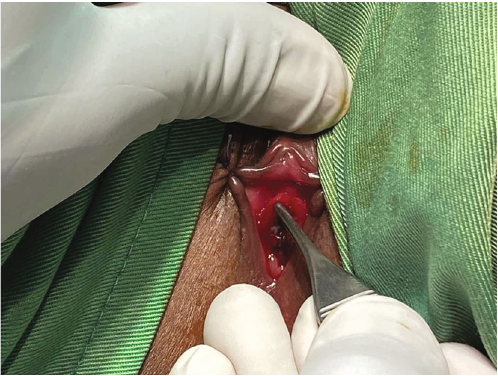
Figure 2: Urethral prolapse in a 7-year-old girl.